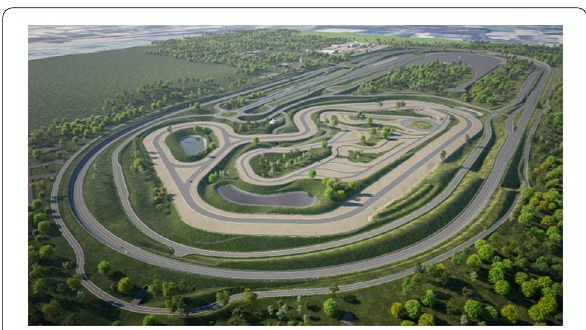
Fig. 2 An aerial view of the ZalaZone road network (Source: